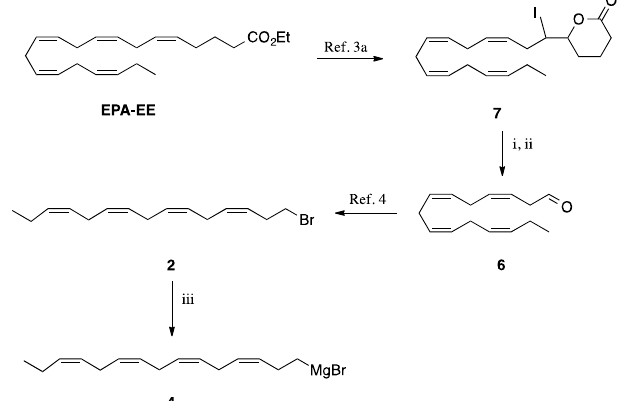
Scheme 2. Synthesis of the key intermediate bromide 2 .